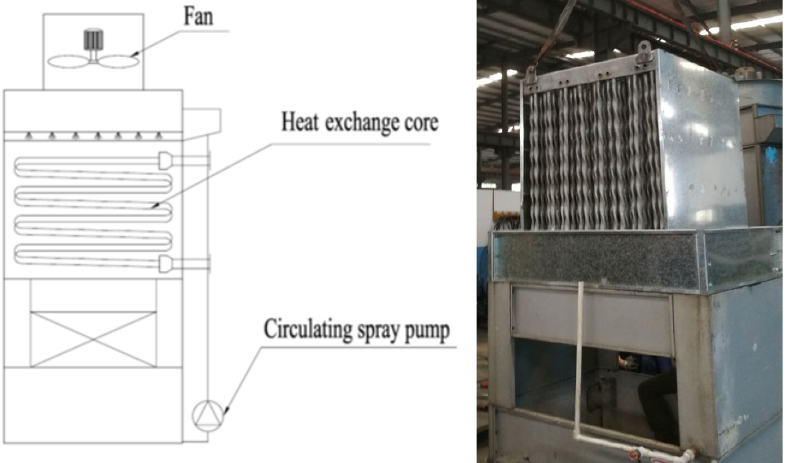
Figure 1. Schematic diagram of the CECT before renovation and photo of the heat exchange coil.